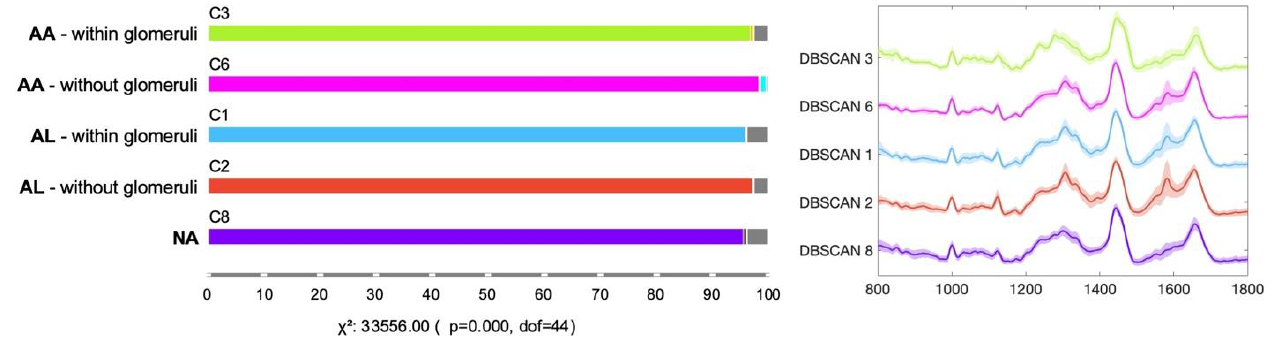
Figure 6. DBSCAN clustering results and representative Raman spectra of each cluster. ( Left ) Out of a total of 12 clusters, 5 dominant clusters were identified. AA glomerular and non-glomerular spectra are primarily grouped as Clusters 3 and 6, respectively. AL glomerular and non-glomerular spectra are primarily grouped as Clusters 1 and 2, respectively. NA tissue is primarily grouped as Cluster 8. The rest of the seven minor clusters are grouped accordingly. Unassigned spectra are marked as gray. ( Right ) Average spectra of the 5 dominant clusters with 1 standard deviation shaded.